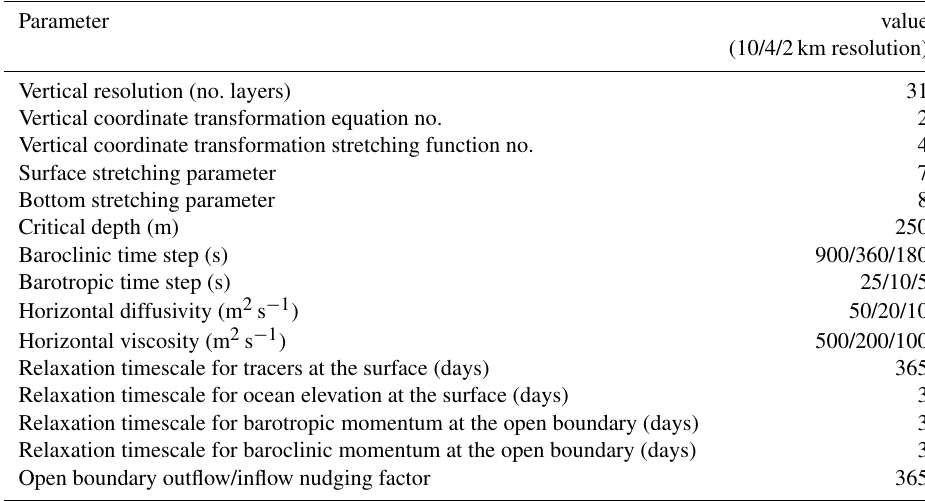
Table C2. Some key model parameters.